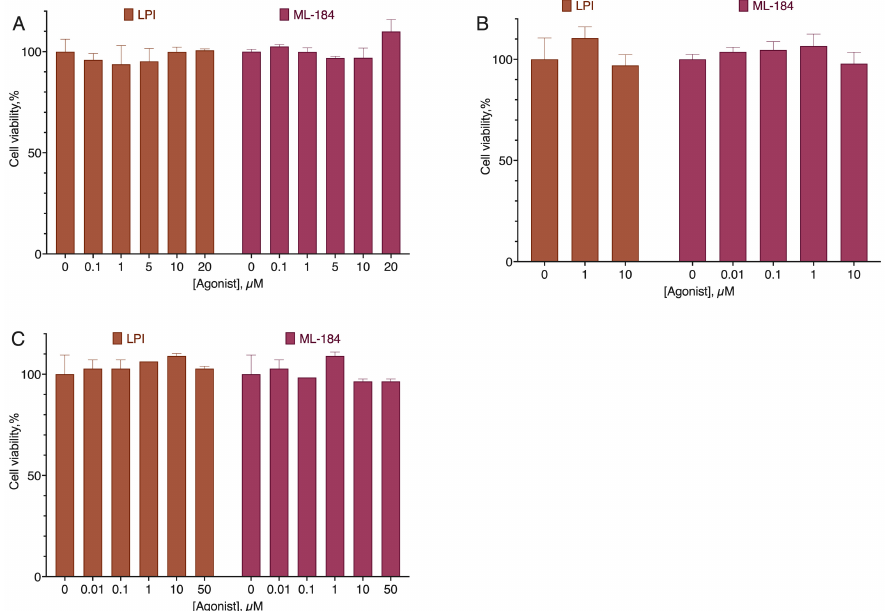
Figure 10. Effect of ML ‐ 184 and LPI on cell lines without the CB2 receptor expression. ( A ) Mia PaCa 2, ( B ) RPMI ‐ 8226, ( C ) Hep G2. Incubation time 72 h, MTT test data, mean±standard error. The dif ‐ ferences were not statistically significant. Amalgamated data of n = 4 experiments.